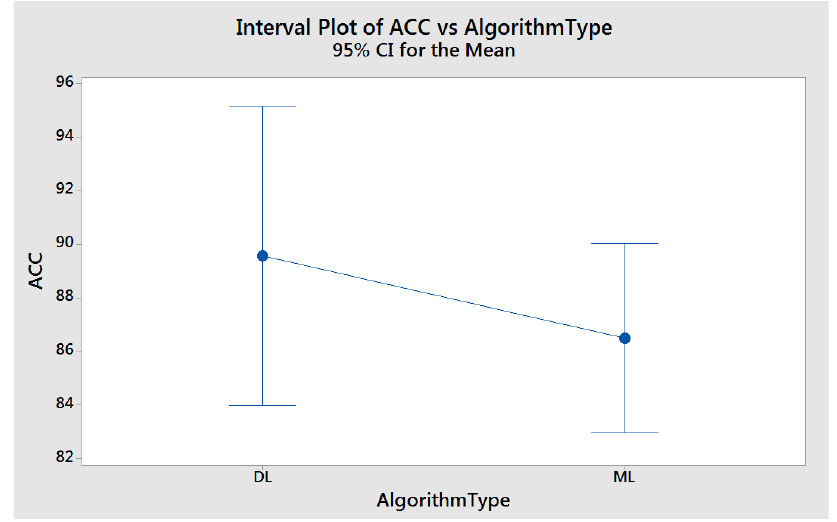
Figure 4. ACC based average increments between DL and ML.